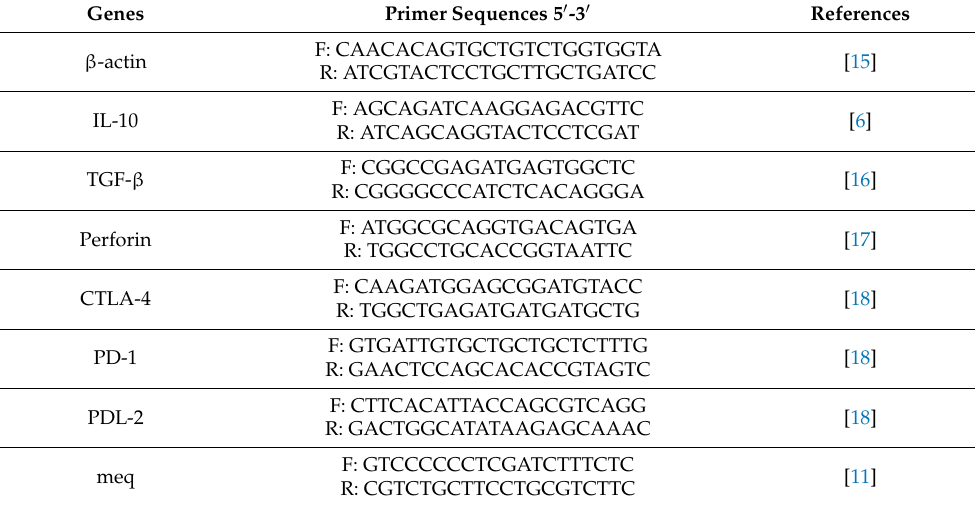
Table 1. Target genes, primer sequences and references used for real-time